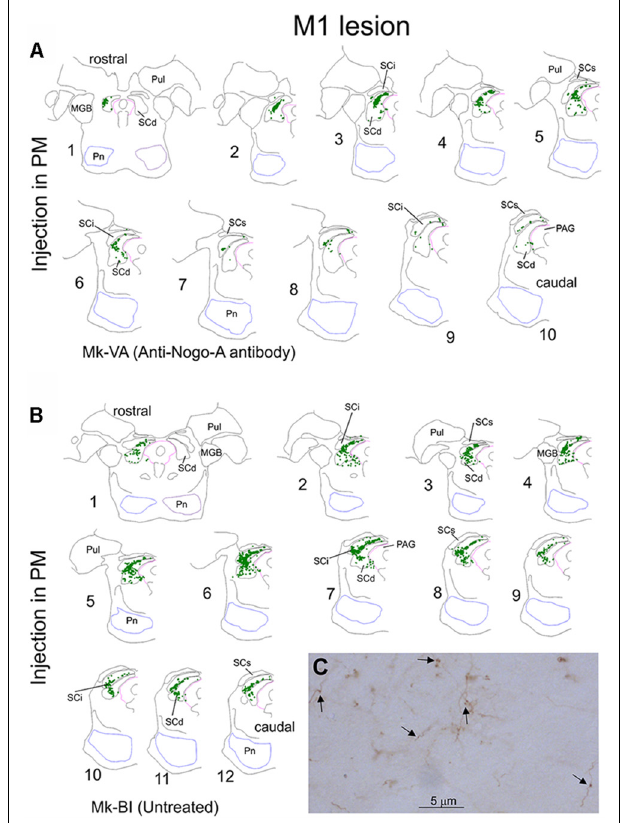
FIGURE 1 | Typical distribution of BDA labeled corticotectal axonal boutons in the ipsilateral superior colliculus (SC) in two representative monkeys subjected to unilateral primary motor cortex (M1) lesion (A) . In both monkeys, BDA was injected in the ipsilesional premotor cortex (PM). In panel (A) , Mk-VA was treated with an anti-Nogo-A antibody whereas in Mk-BI was untreated (B) . Only the ipsilesional SC is shown. Axonal boutons are depicted with green dots. The histological sections are arranged from rostral to caudal. The (C) illustrates a typical BDA labeled terminal field in the SC, with axon segments as well as a few boutons pointed by arrows. See list of abbreviations.